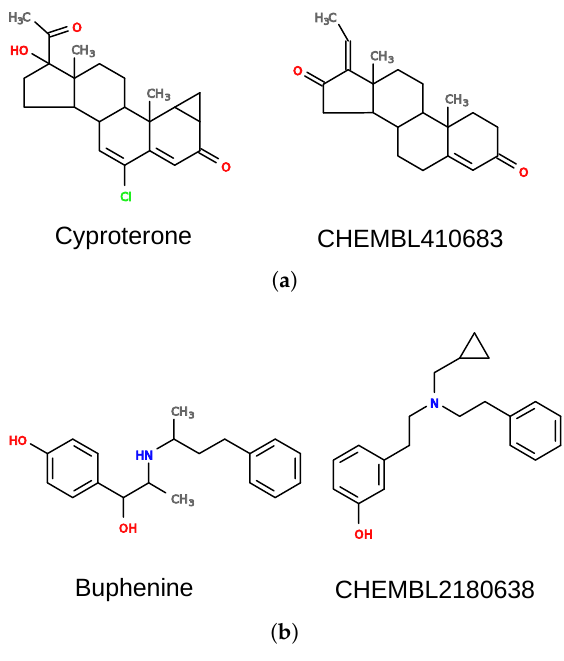
Figure 6. Examples of drugs (left) with incorrectly predicted activity and ligands of receptors (right) they were compared to. See Section 4 for more details. ( a ) cyproterone and guggulsterone (CHEMBL410683), a native ligand of pregnane X receptor; ( b ) buphenine and the native ligand of kappa-type opioid